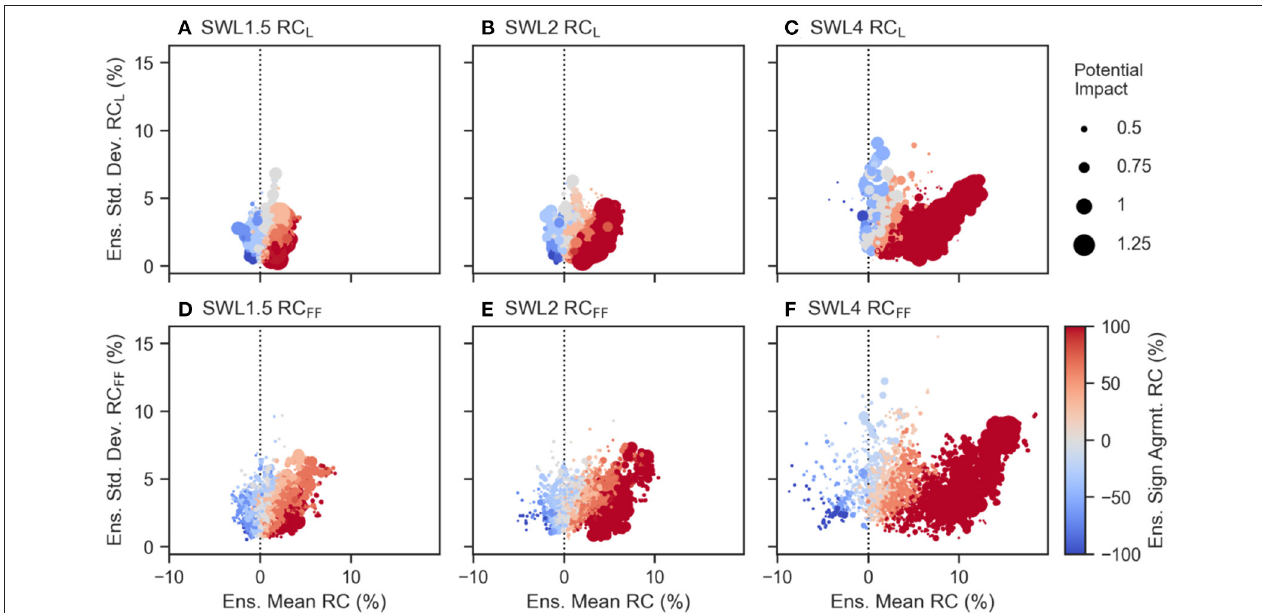
FIGURE 6 | Scatter plot of ensemble mean (x-axis) and standard deviation (y-axis) for relative changes of potential impact with respect to the historical period for landslides (A–C) and flash floods (D–F) under various scenarios: (A,D) GWL1.5; (B,E) 2.0; and (C,F) 4.0. The color of the dot represents the ensemble sign agreement. The size of the circle is proportional to the potential impact reached during each